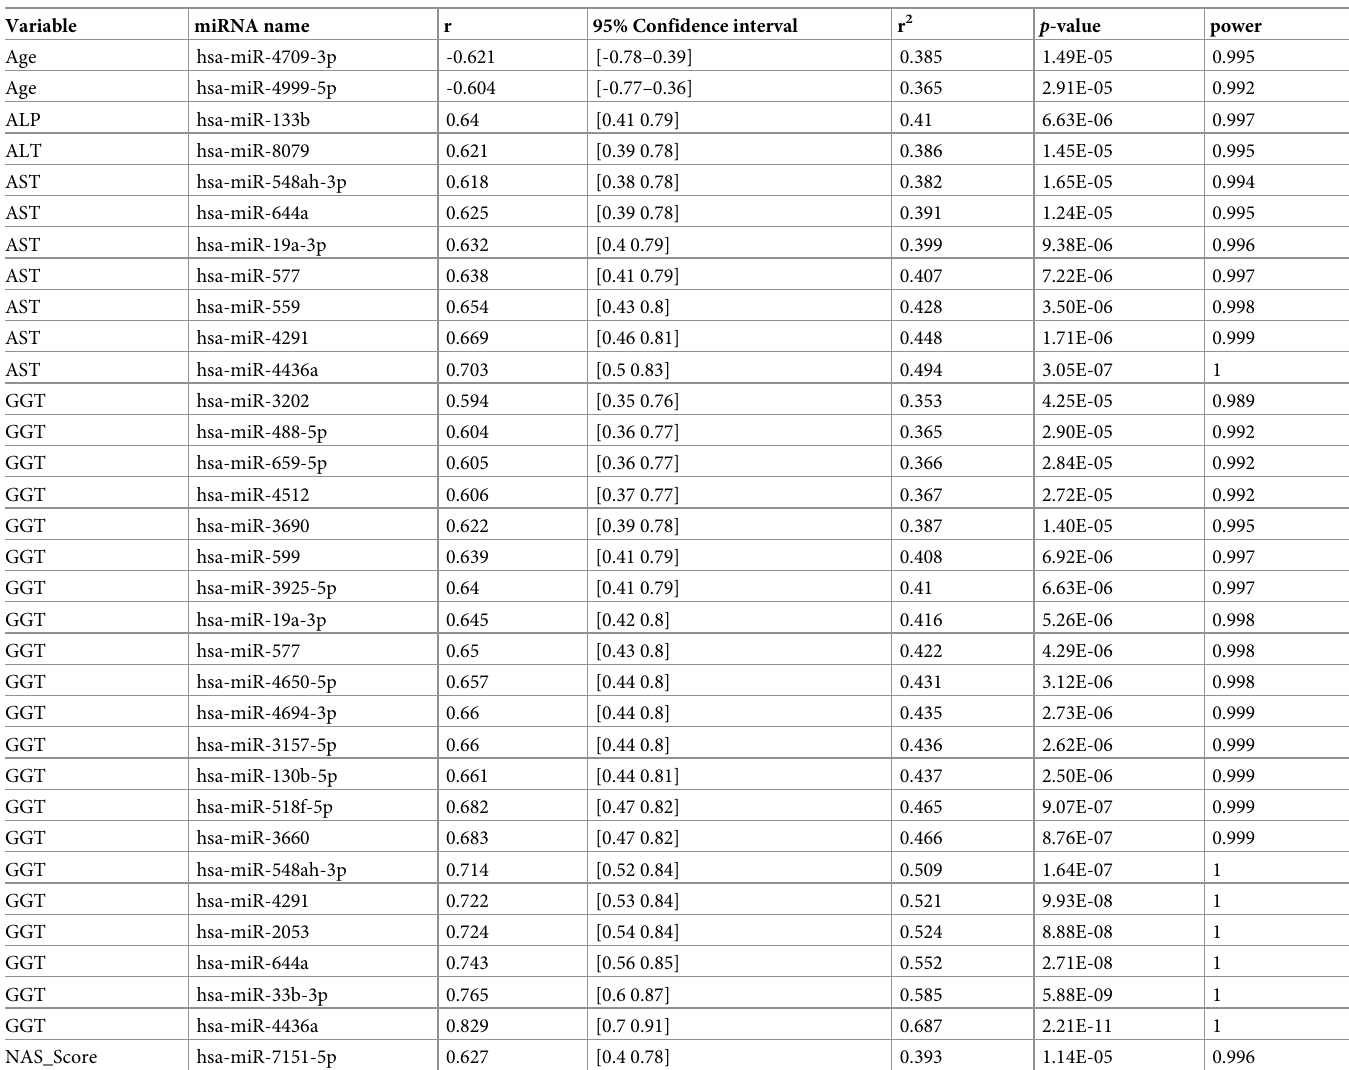
Table 2. Correlations between miRNA expression and clinical